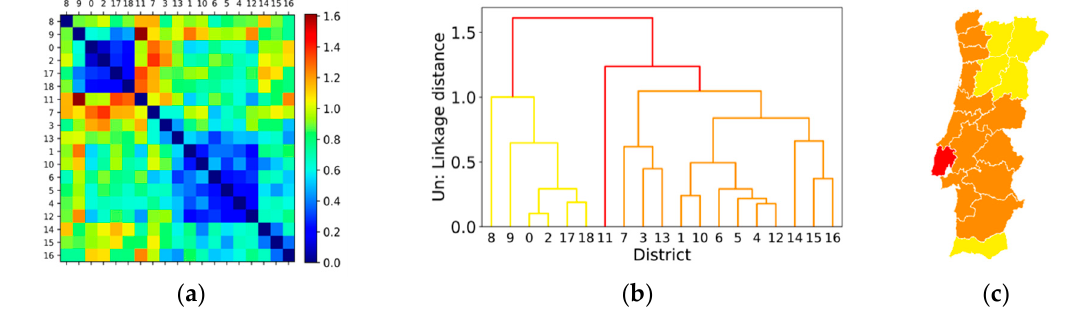
Figure 10. Unknown causes (Un): ( a ) Dissimilarity matrix; ( b ) Clusters by relative annual profile of distribution; ( c ) Clusters in geographic location (cophenetic coefficient: 0.74).